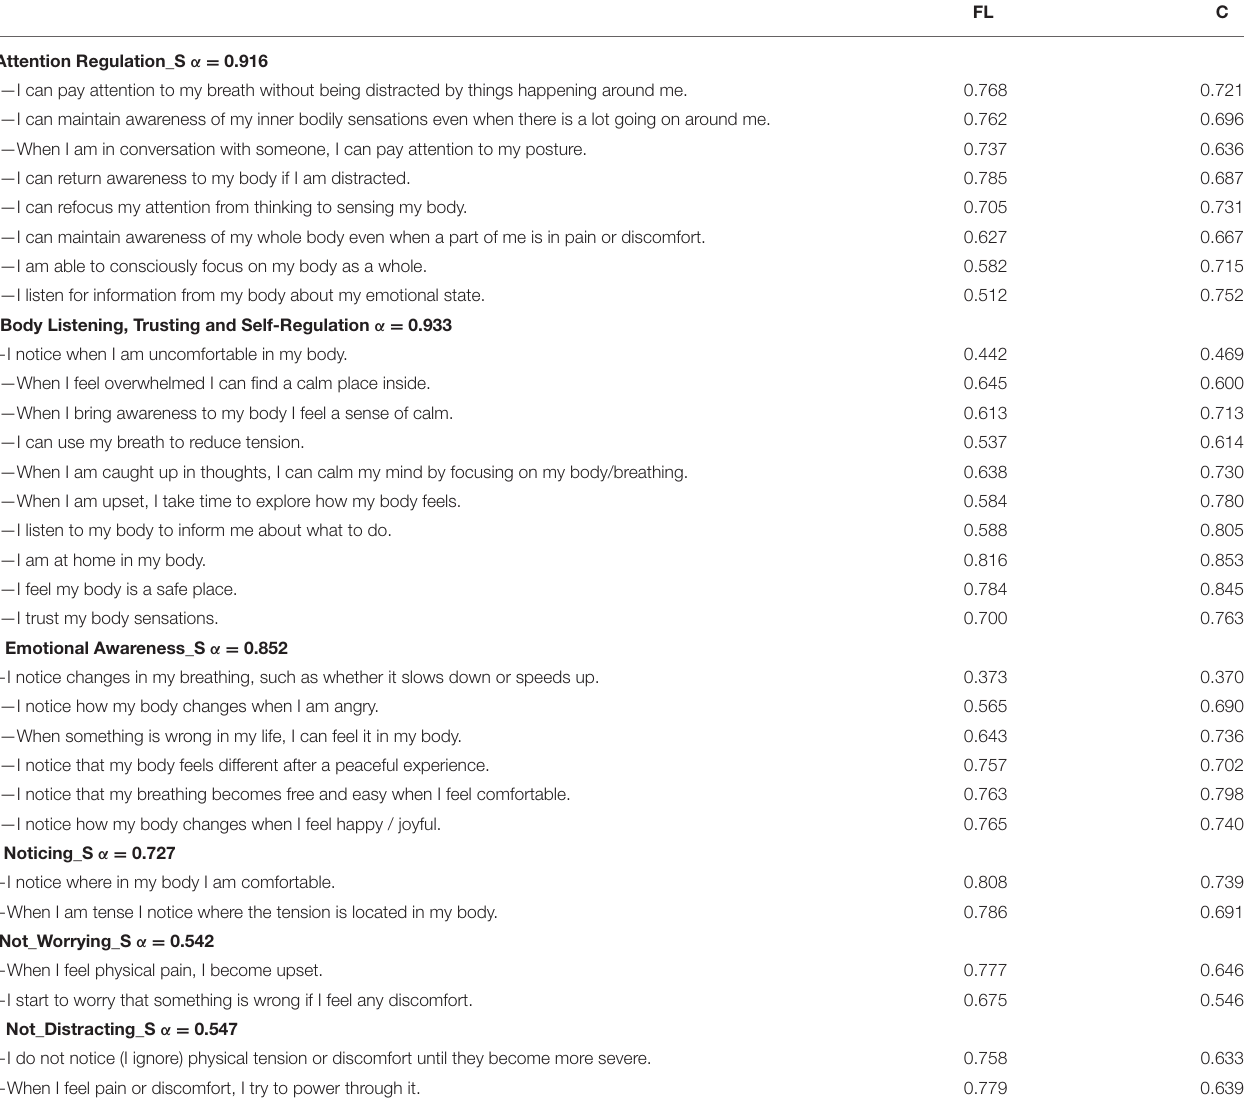
TABLE 10 | Exploratory PCA of the MAIA items in Spanish